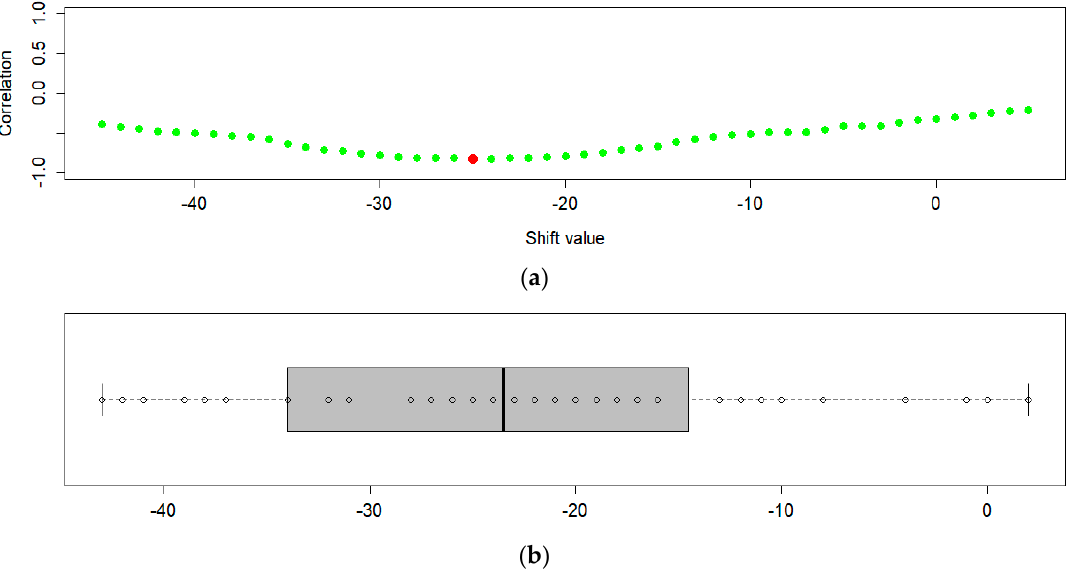
Figure 6. (a) An example of the determined best shift value compared to all correlation values from tested shift range; and (b) boxplot chart with individual best shift values from which the global shift value has been determined as median value.